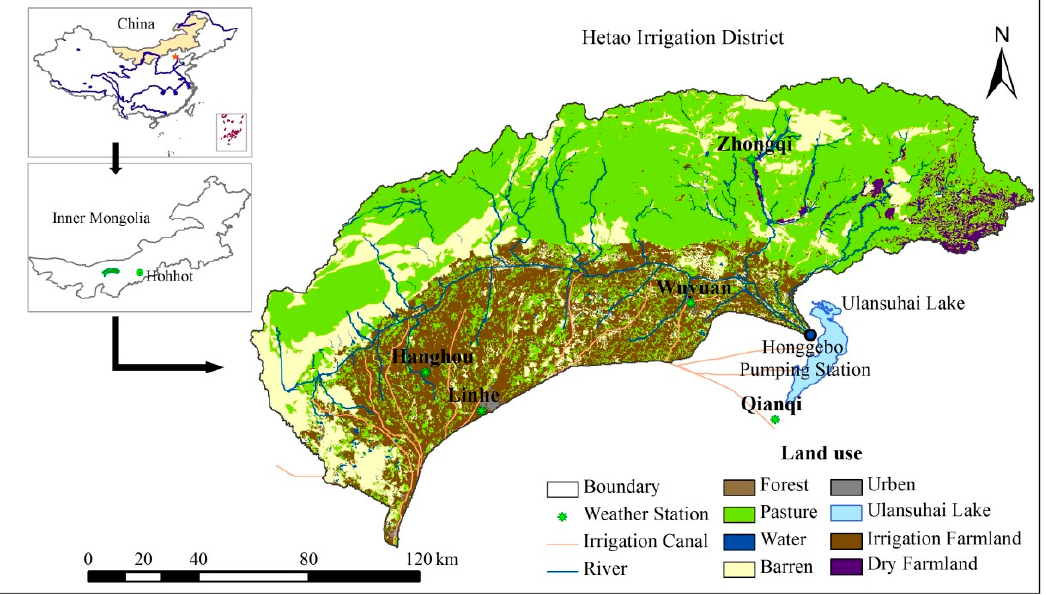
Figure 1. Location of the Hetao Irrigation District and its land use classifications.